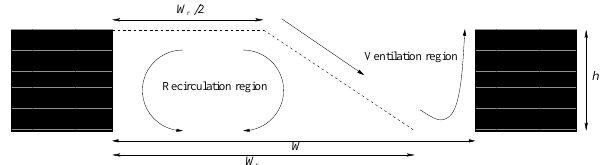
Figure 3. Wide canyon leading to an isolated roughness